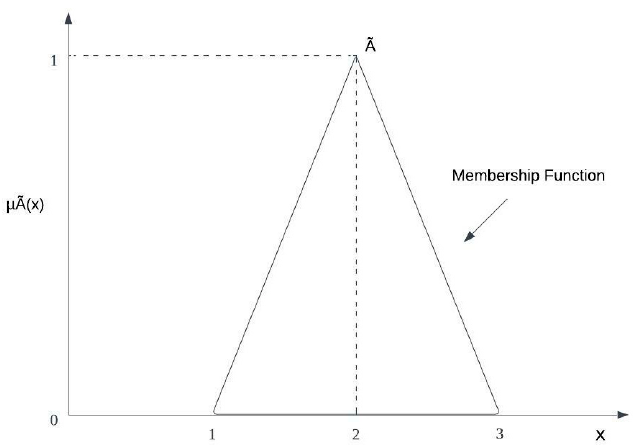
Figure 5. Membership function [106–112].